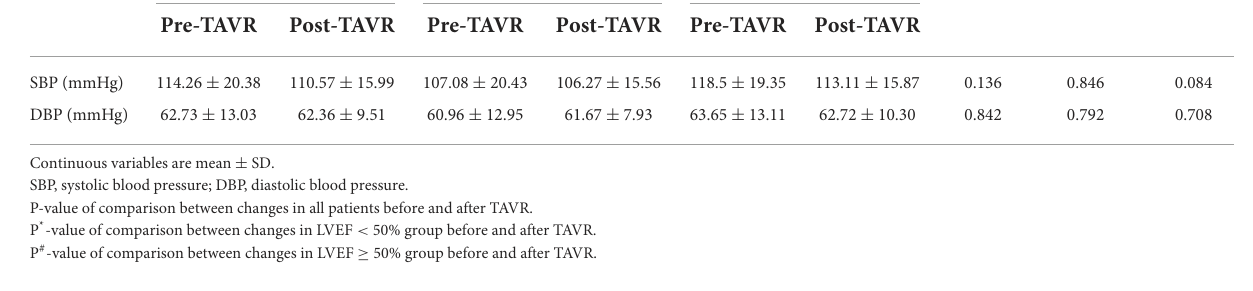
TABLE 5 The comparison of SBP and DBP at baseline and the end of the study. Variable